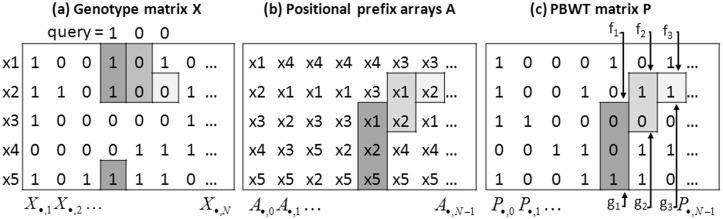
Outline of the search strategy with PBWT. A set of genotype sequences X={x1,…,x5} illustrated in (a) is sorted by the algorithm described in Durbin (2014) to obtain the positional prefix arrays A illustrated in (b). Each element Pi,j of PBWT matrix illustrated in (c) is (j+1)th letter of sequence Ai,j. By computing rank operations with regard to kth query letter on P·,k−1, one can update an interval corresponding to k-mer match between the query and X. In this figure, the search starts from fourth allele. The first interval (f1,g1] is initialized by rank operations on P·,3 with regard to first query letter ‘1’. The second interval (f2,g2] is obtained by rank operations on P·,4 with regard to the second query letter ‘0’ and (f1,g1]. Similarly, the third interval (f3,g3] is obtained by rank operations on P·,5 with regard to the third query letter ‘0’ and (f2,g2]. See Sections 2.2 and 3.3 for more details